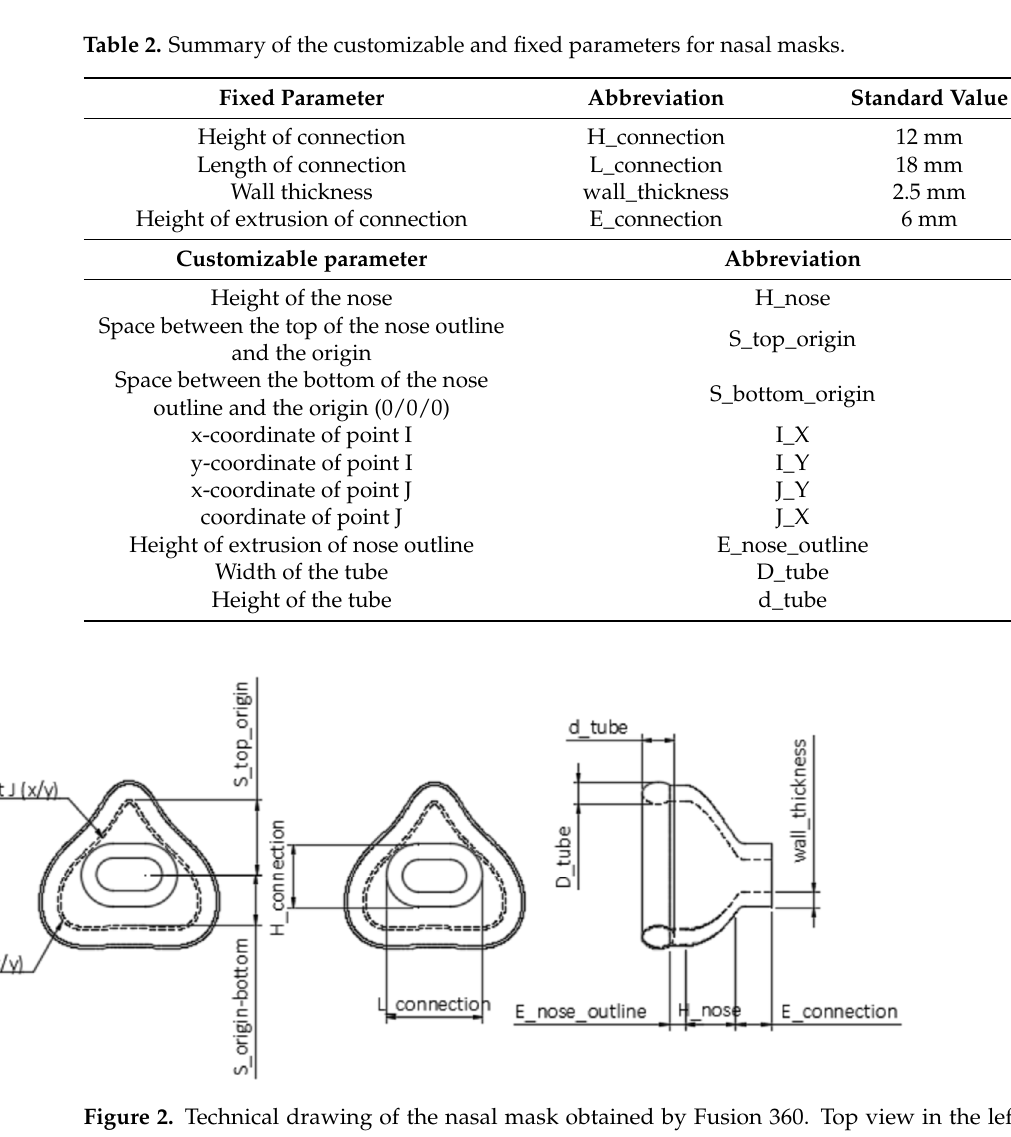
Figure 3. Final user workflow. Automatic steps are indicated by dotted lines. 2.4. Patient Data Acquisition and Mask Individualization To produce a prototype of the masks, a neonatal resuscitation training dummy (ALS Baby Trainer, Laerdal Medical GmbH, Puchheim, Germany) was scanned with two different technologies. A portable and a facial scanner were selected. The portable intraoral scanner (Trios 3, 3Shape A/S, Copenhagen, Denmark) was used to acquire data around the nose, while the facial scanner (3dMd Flex System, 3dmD Limited, London, UK) was employed for obtaining information on the complete face. The scan from the facial scanner was used for the oronasal mask, whereas that generated by the intraoral scanner was employed for the nasal mask. These two scanning processes are presented in Figure 4. Figure 4. Facial scan of a neonatology dummy. ( A ) Process of scanning with the 3dMd facial scanner with corresponding stl. file; ( B ) Scanning with Trios3 intraoral scanner and respective stl. file.